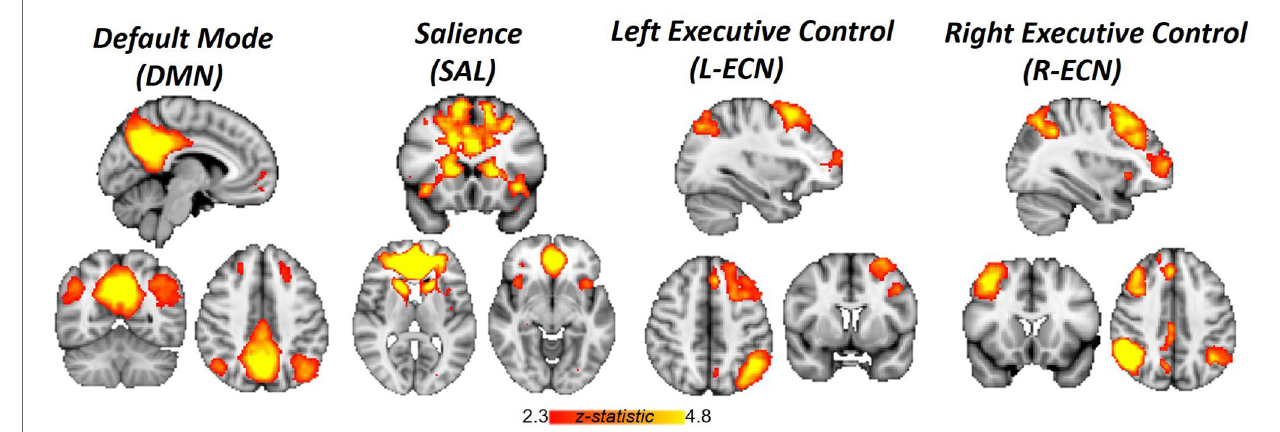
FIGURE 1 | Networks identified by independent component analysis. Spatial maps generated with group ICA and cross-correlated to resting-state template masks include Default Mode Network, Salience Network, and Left and Right Executive Control